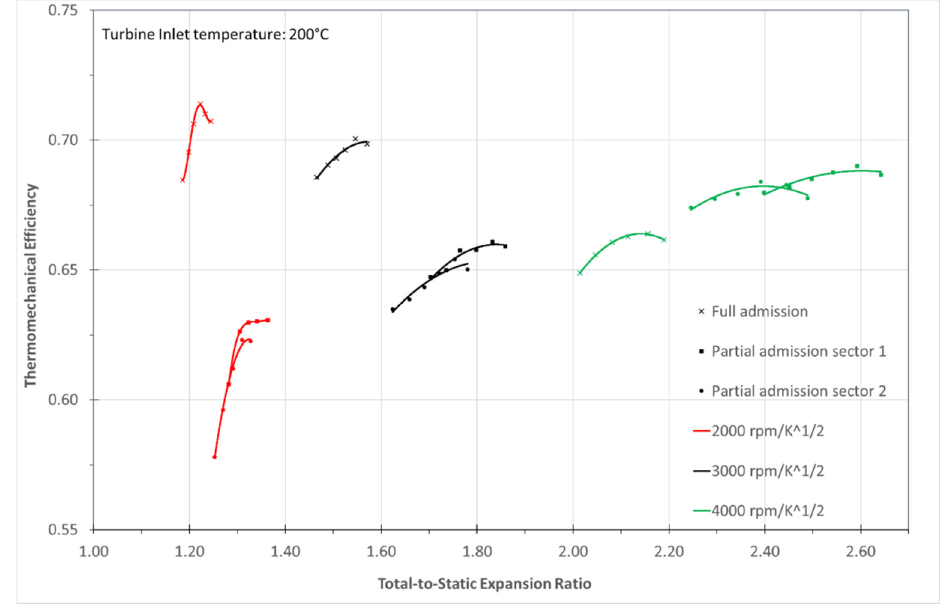
Figure 11. Thermomechanical efficiency vs. expansion ratio in partial and full admission condi-